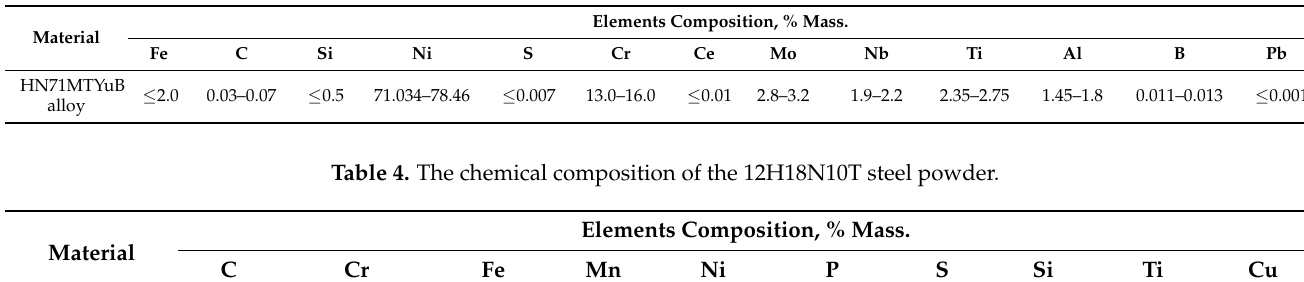
Figure 2. An ‘electromagnet case’ part: ( a ) 3D-model; ( b ) cross-section. Table 3. The chemical composition of the HN71MTYuB alloy powder. Elements Composition, % Mass.